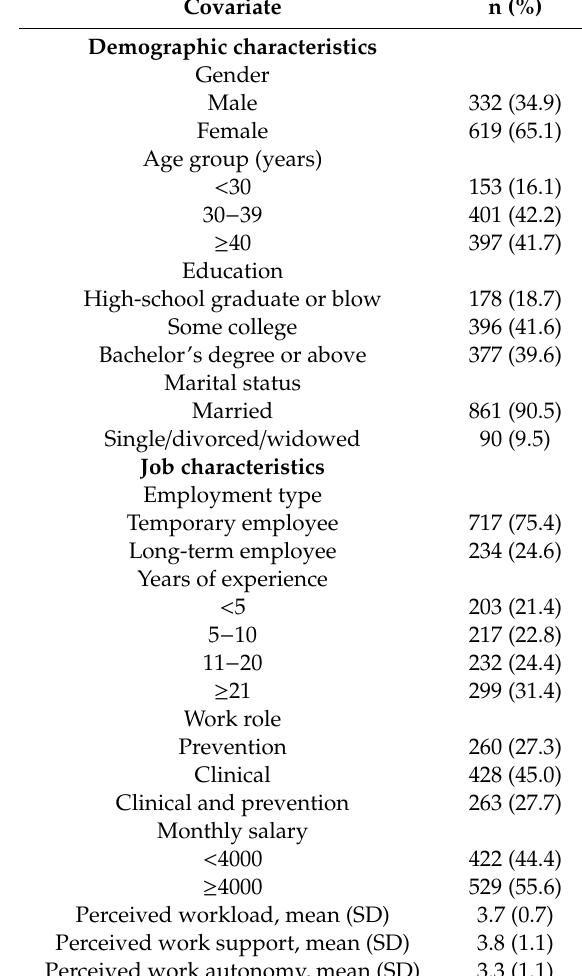
Table 1. Demographic and job characteristics of participants (n = 951).